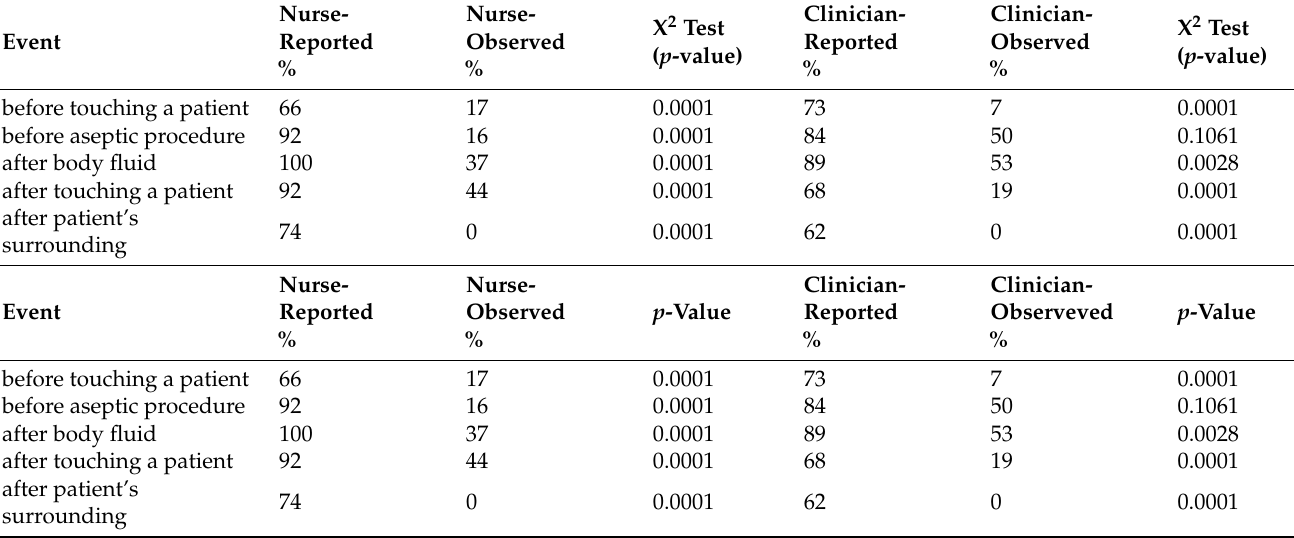
Table A3. Reported versus observed hand hygiene practices among nurses and